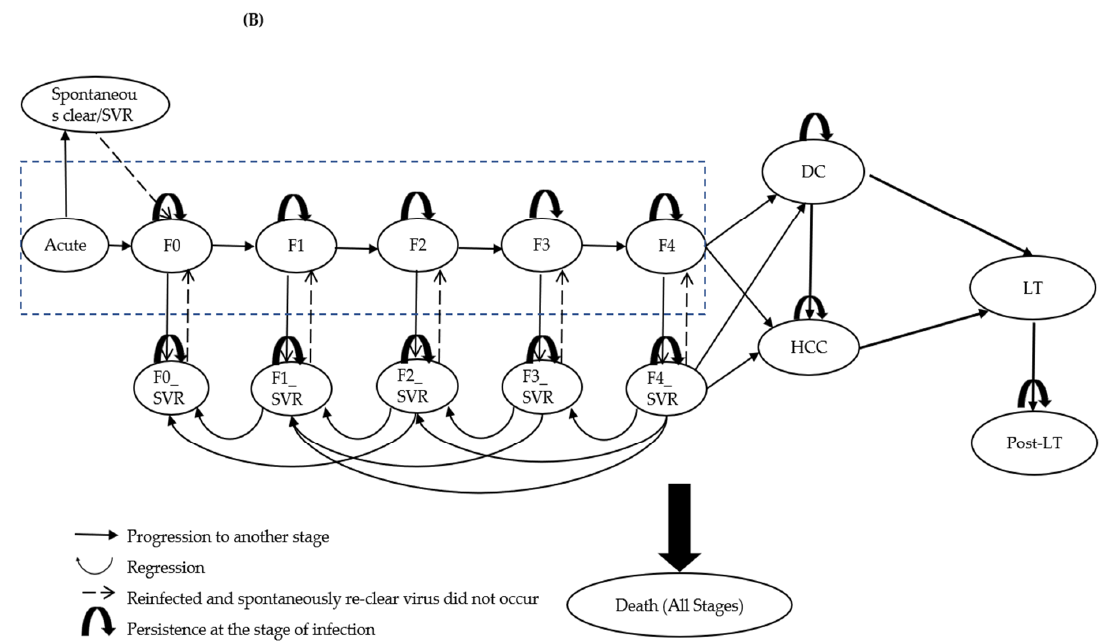
Figure 1. Decision analytical Markov model. ( A ) depicts treatment strategies with consideration for therapy and timing, each strategy analysis starts at the node marked with an ‘M’; ( B ) shows the Markov model. The Markov model structure is similar for all strategies, within each strategy, the fibrosis state at which the treatment that was initiated was selected. The square in the Markov model represents initial cohorts. HCV, Hepatitis C Virus; DCV, Daclatasvir; ASV, Asunaprevir; IFN, interferon; RBV, ribavirin; SVR, sustained virologic response; F0, no fibrosis; F1, portal fibrosis with septa; F2, portal fibrosis with rare septa; F3, numerous septa without cirrhosis; F4, compensated cirrhosis; DC, decompensated cirrhosis; HCC, hepatocellular carcinoma; LT, liver transplantation.